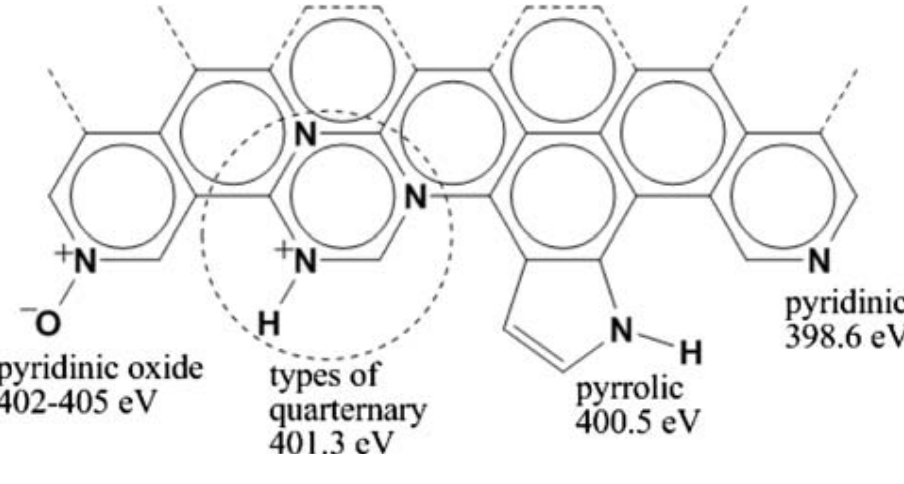
Figure 2. Types of nitrogen species that can be incorporated into graphitic carbon and the XPS binding energies for each type (Biddinger, E.J.; von Deak, D.; Ozkan, U.S. Nitrogen- containing carbon nanostructures as oxygen-reduction catalysts. Top. Catal. 2009 , 52, 1566–1574)